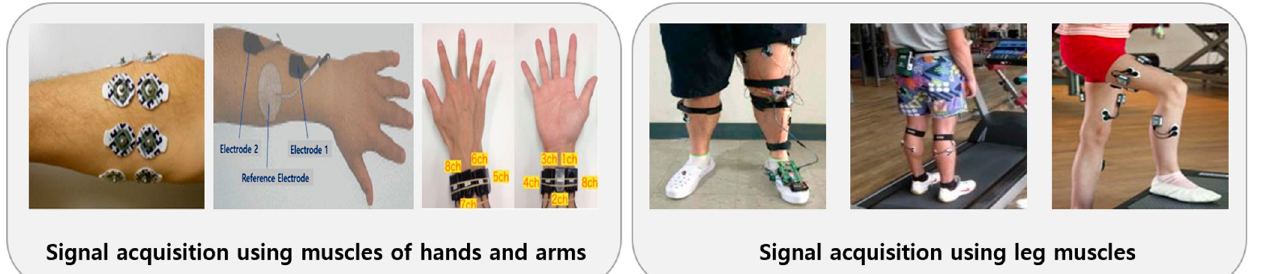
Figure 2. sEMG signal acquisition using various muscles.